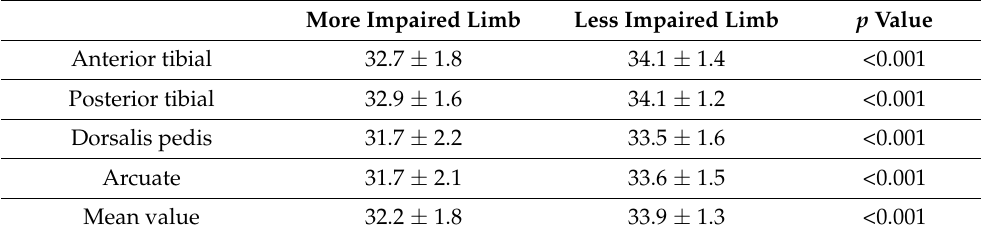
Table 2. Measurements obtained bilaterally with infrared thermography for both limbs. More Impaired